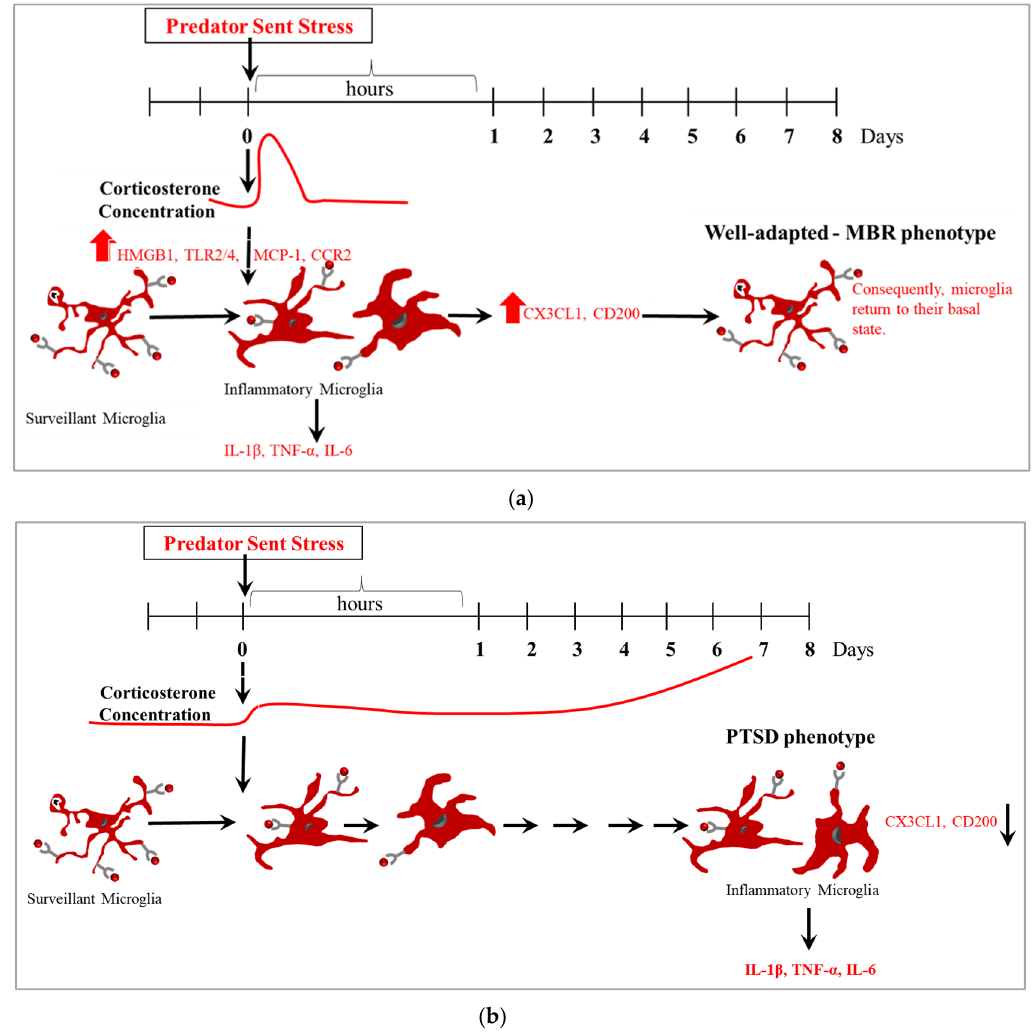
Figure 11. Either neuroprotective or neurotoxic microglial function may be involved at different stages of the development of PTSD phenotype. ( a ) Well-adapted (MBR) phenotype. ( b )